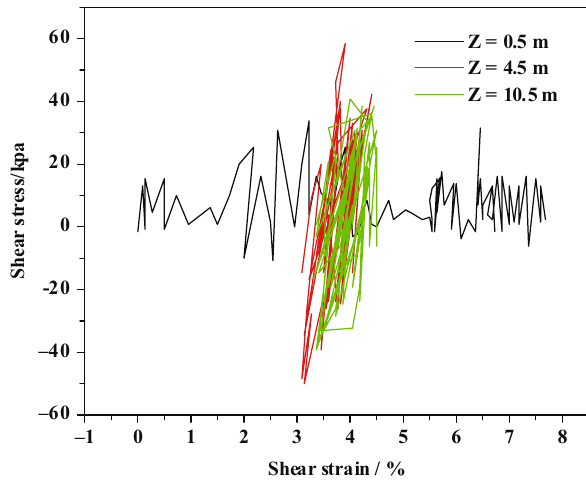
Figure 6: Dynamic response of soil mass at each depth at slope shoulder.